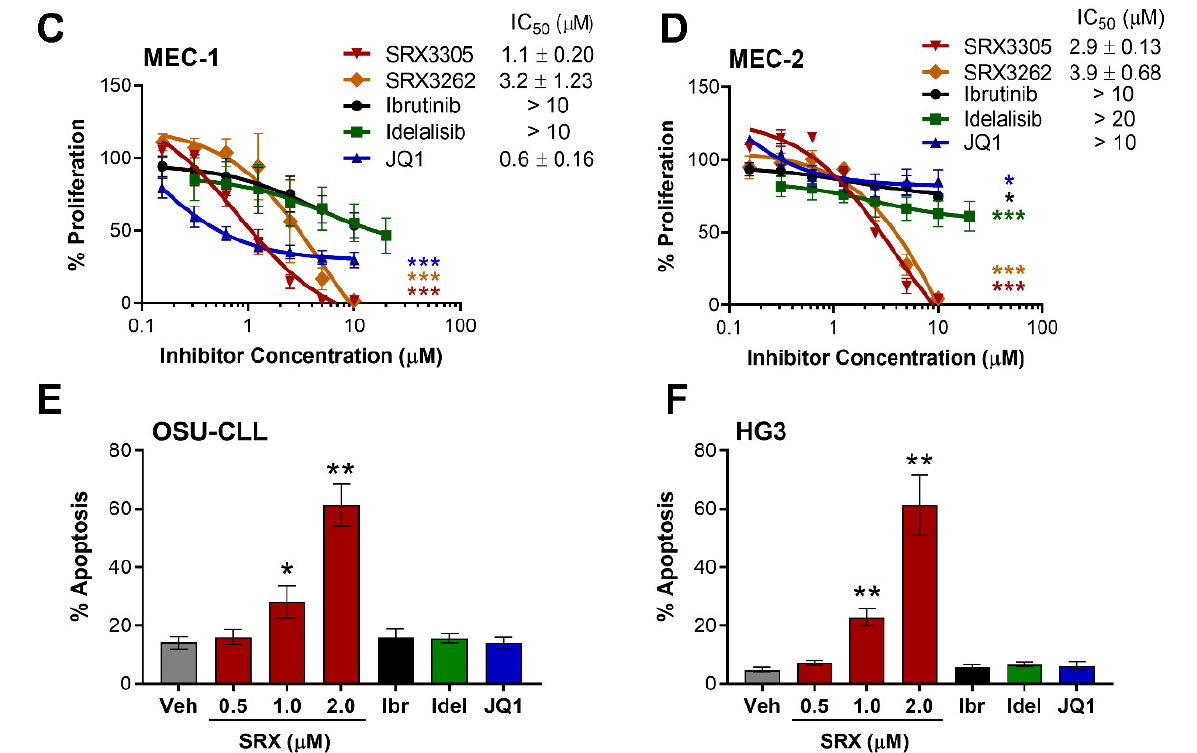
Figure 1. SRX3305 is cytotoxic to CLL cells in a dose-dependent manner. Four CLL cell lines, OSU-CLL ( A ), HG-3 ( B ), MEC-1 ( C ), and MEC-2 ( D ), were treated with increasing concentrations of SRX3262, SRX3305 (BTK/PI3K/BRD4 triple-inhibitor), ibrutinib (BTK inhibitor), idelalisib (PI3K in- given as % proliferation normalized to vehicle. Error bars indicate SEM ( n = 3 independent experi- ments per cell line). IC 50 values (mean ± SEM) are noted for each inhibitor within the in-figure leg-